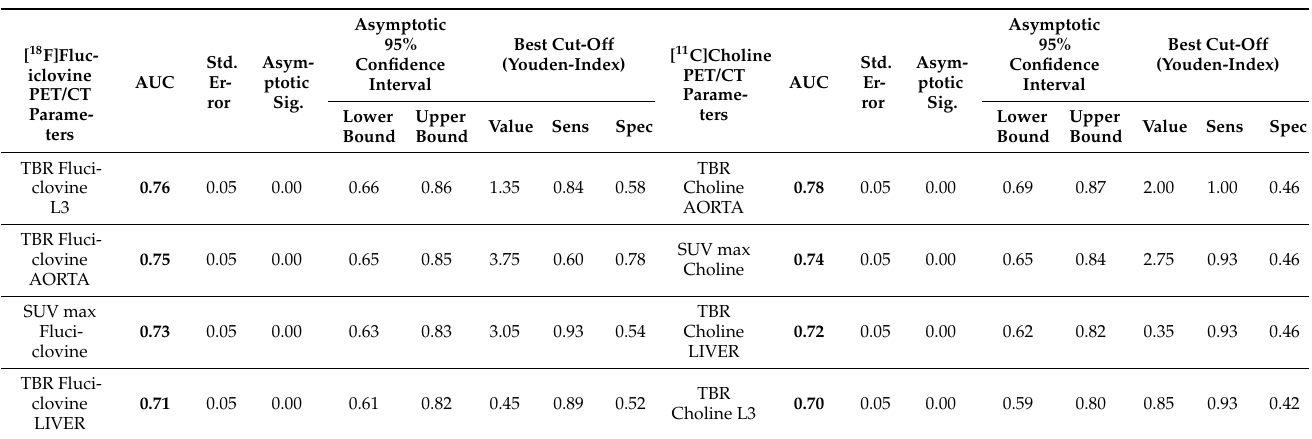
Figure 1. Receiver operating characteristics (ROC) curves of [ 18 F]Fluciclovine ( A ) vs. [ 11 C]Choline PET/CT ( B ) performance for malignant lesion detection, using semi-quantitative parameters (lesion based, n = 45/95). Table 4. Comparison of [ 18 F]Fluciclovine vs. [ 11 C]Choline PET/CT performance for malignant lesion detection, using semi- quantitative parameters (lesion based, n = 45/95). Areas under the ROC curves (AUCs) are listed (in bold) in descending order. Best cut-off values for each parameter and corresponding sensitivity (sens) and specificity (spec) are also